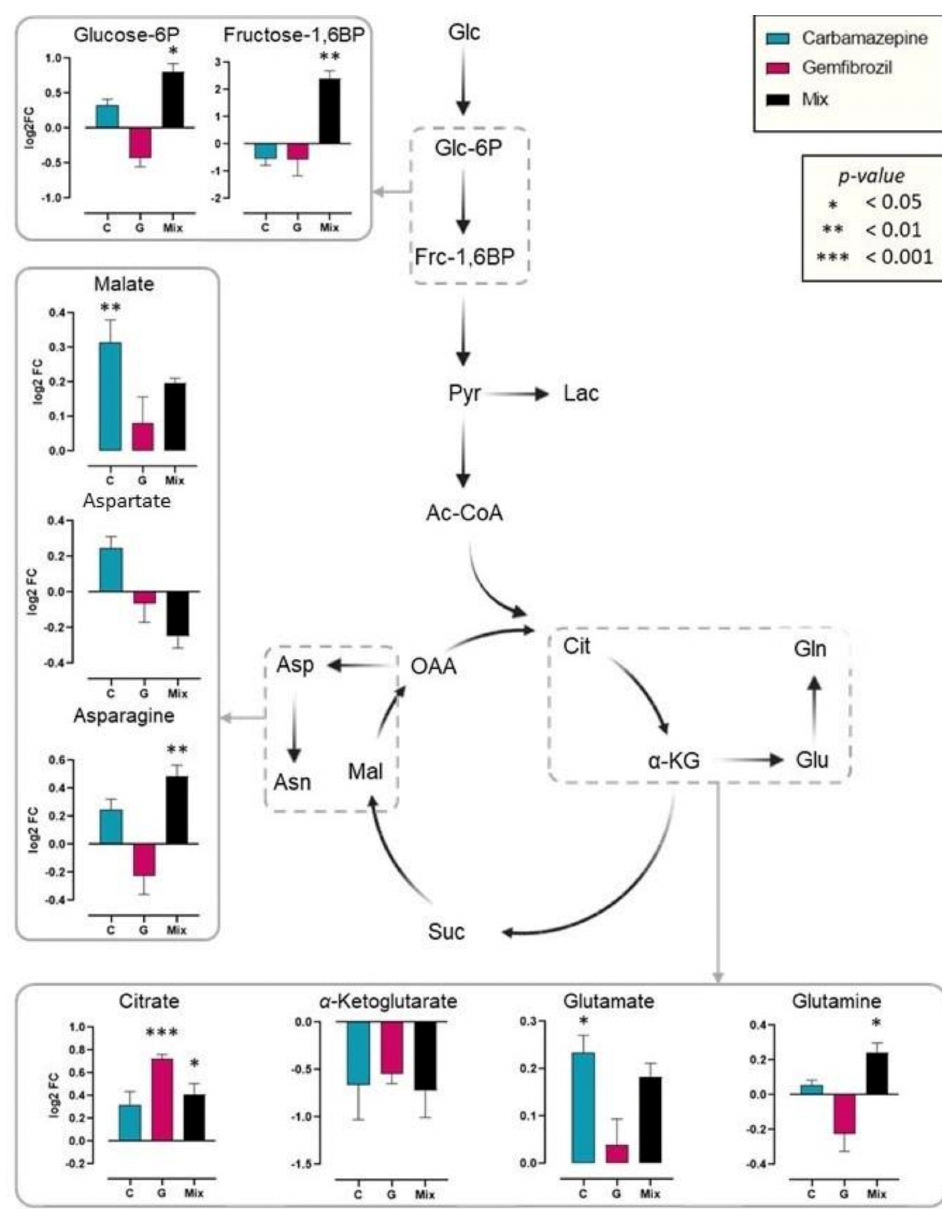
Figure 3. Illustrating the metabolic impact of pharmaceuticals on daphnids. A. Statistical signifi‑ cance is displayed for diclofenac, gabapentin, metformin and their mixture compared with the OECD control. B. Carbamazepine, gemfibrozil and their mixture are compared with DMSO control used as their carrier solvent. Glc = glucose, Glc‑6P = glucose 6‑phosphate, Ribu‑5P = ribulose 5‑phosphate, Rib‑5P = ribose 5‑phosphate, Frc‑1,6BP = fructose 1, 6‑bisphosphate, Pyr = pyruvate, Lac = lactate, Ac‑ CoA = acetyl coenzyme A, Cit = citrate, α ‑KG = α ‑ketoglutarate, Glu = glutamate, Gln = glutamine, Suc = succinate, Mal = malate, OAA = oxaloacetate, Asp = aspartate, Asn = asparagine. Statistical significance was calculated by ANOVA followed by Tukey’s test for multiple comparisons. * p < 0.05, ** p < 0.01, *** p < 0.001. The log2FC values used in the metabolic network reconstruction figure are provided in the Supplementary